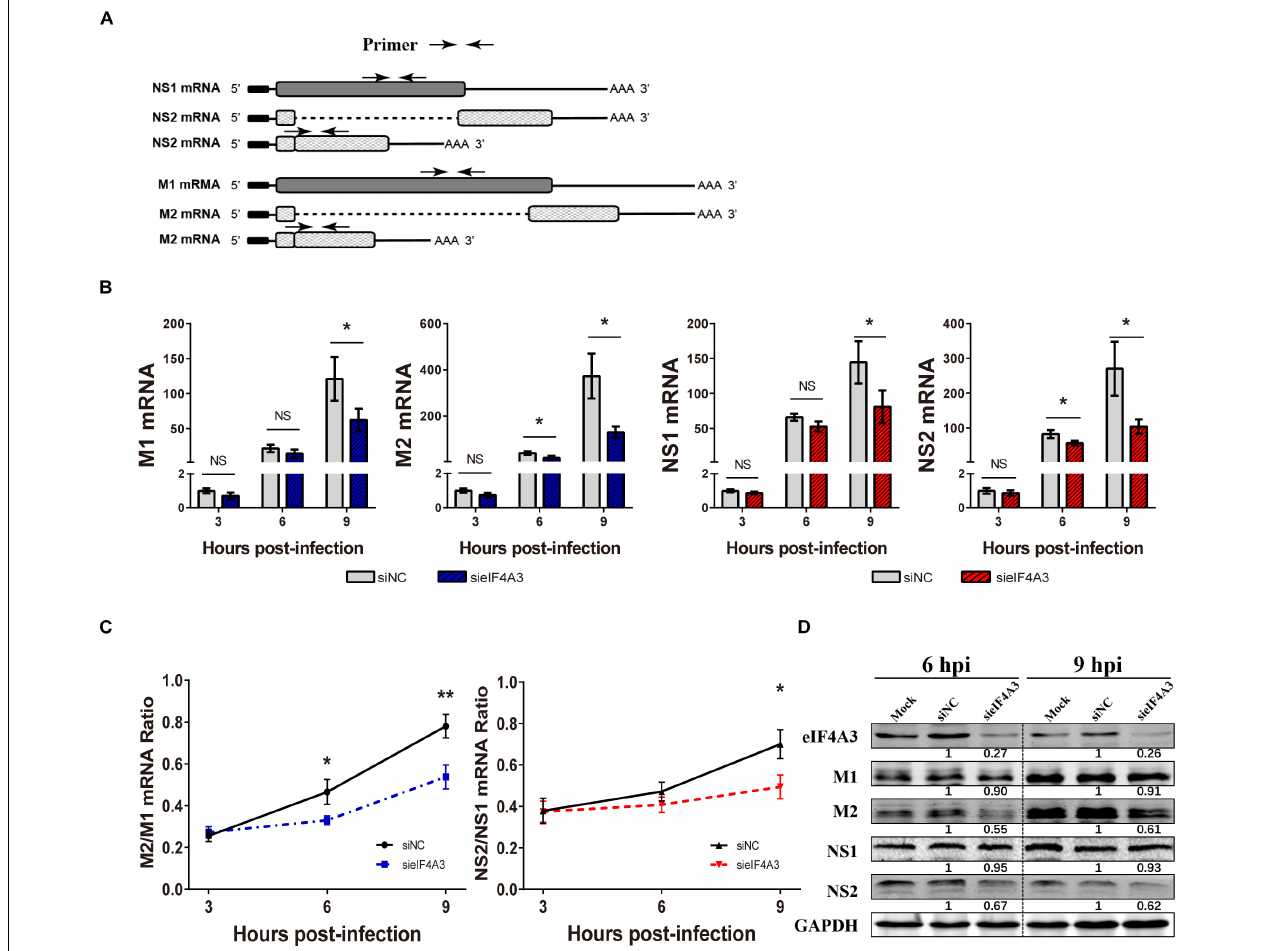
FIGURE 6 | Effect of eIF4A3 knockdown on the accumulation of influenza virus mRNAs and proteins. (A) Schematic representation of the primers used for RT-qPCR. M1 mRNA along with its alternatively spliced products M2 mRNA, NS1 mRNA and its alternatively spliced product NS2 mRNA, is depicted. The arrowheads show primer positions for detection of various mRNAs in the following experiments. (B) A549 cells were treated with negative control (NC) or eIF4A3 siRNA for 36 h and infected with influenza virus V at an MOI 2 for the indicated time points. The NS1, NS2, M1, and M2 mRNA copy numbers were determined at the indicated times post-infection by strand specific RT-qPCR and were normalized to the level of the same mRNA species at 3 hpi in cells treated with the NC siRNA. The data are expressed as the mean ± SD of three independent experiments and the significance was calculated using an unpaired t -test ( ∗ p < 0.05). (C) The ratios of NS2/NS1 and M2/M1 mRNA levels in eIF4A3-silenced or negative control cells. The data are shown as means ± SD ( n = 3) and the significance was calculated using an unpaired t -test ( ∗ p < 0.05; ∗∗ p < 0.01). (D) A549 cells treated with eIF4A3 or NC siRNA were infected with influenza virus V at an MOI of 5. At 6 and 9 hpi, cell lysates were subjected to western blot analysis using antibodies for the eIF4A3, M1, M2, NS1, NS2, and GAPDH proteins. GAPDH was used as loading